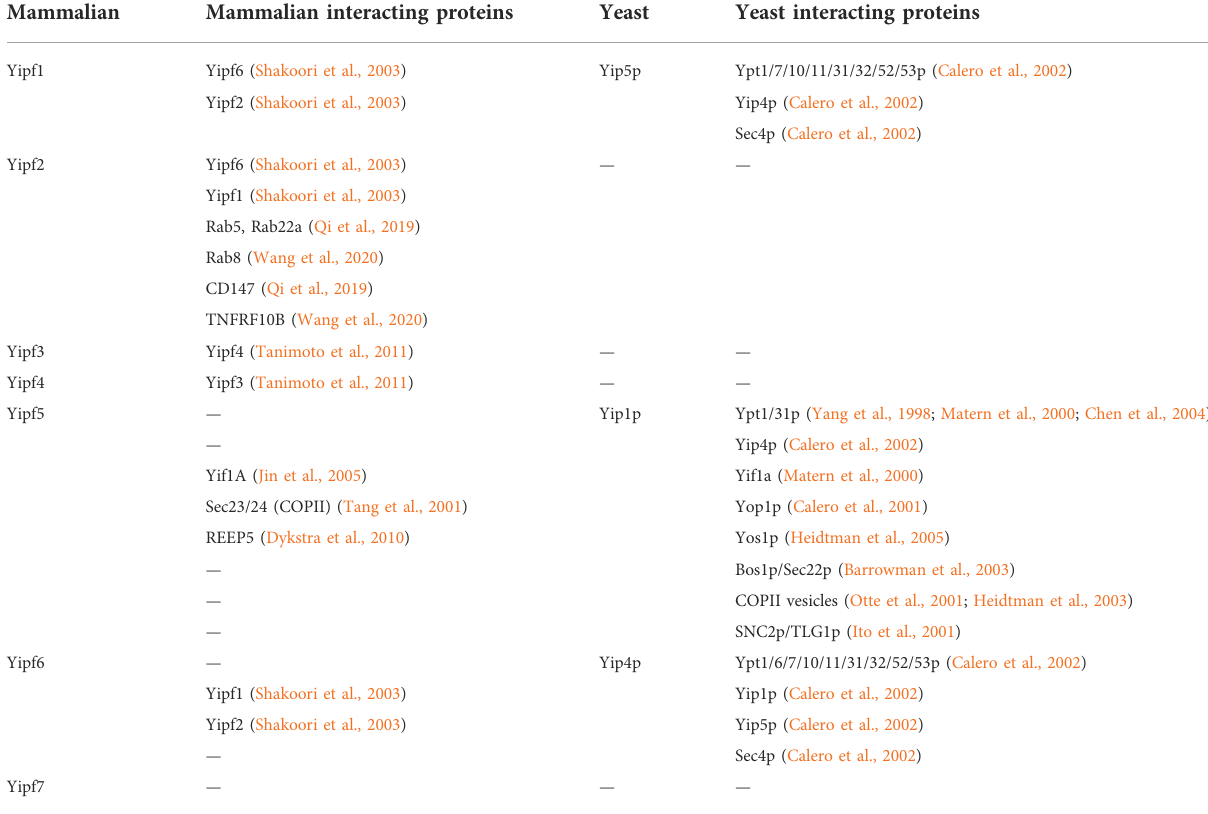
TABLE 2 Yipf family interacting proteins.